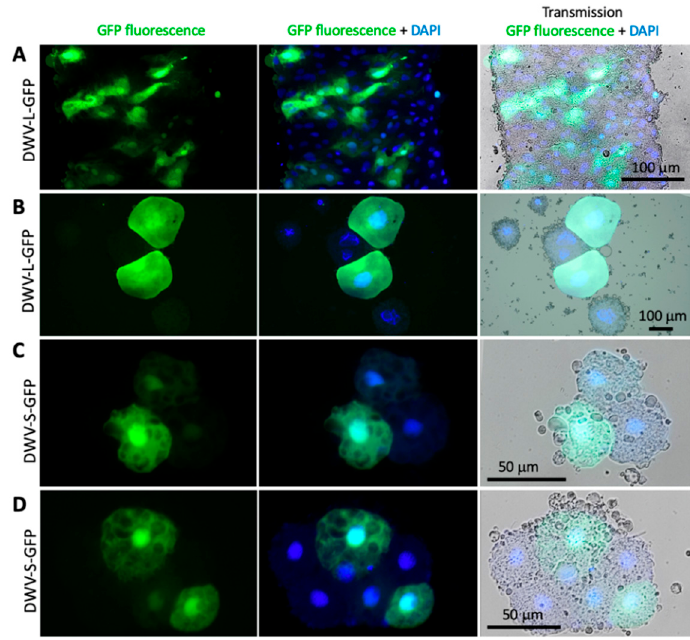
Figure 5. Localization of GFP in the honey bee cells infected with GFP-tagged DWV. Fluorescent microscopy of the cells of the pupae 72 h post injection with the filtered extracts containing 10 7 genome equivalents (GE) of DWV-S-GFP ( A , B ) or DWV-S-GFP ( C , D ). Left panels, GFP fluorescence (green); middle panels, GFP fluorescence (green) and DAPI nuclear DNA staining (blue); right panels, microscopy transmission images combined with GFP fluorescence and DAPI staining.